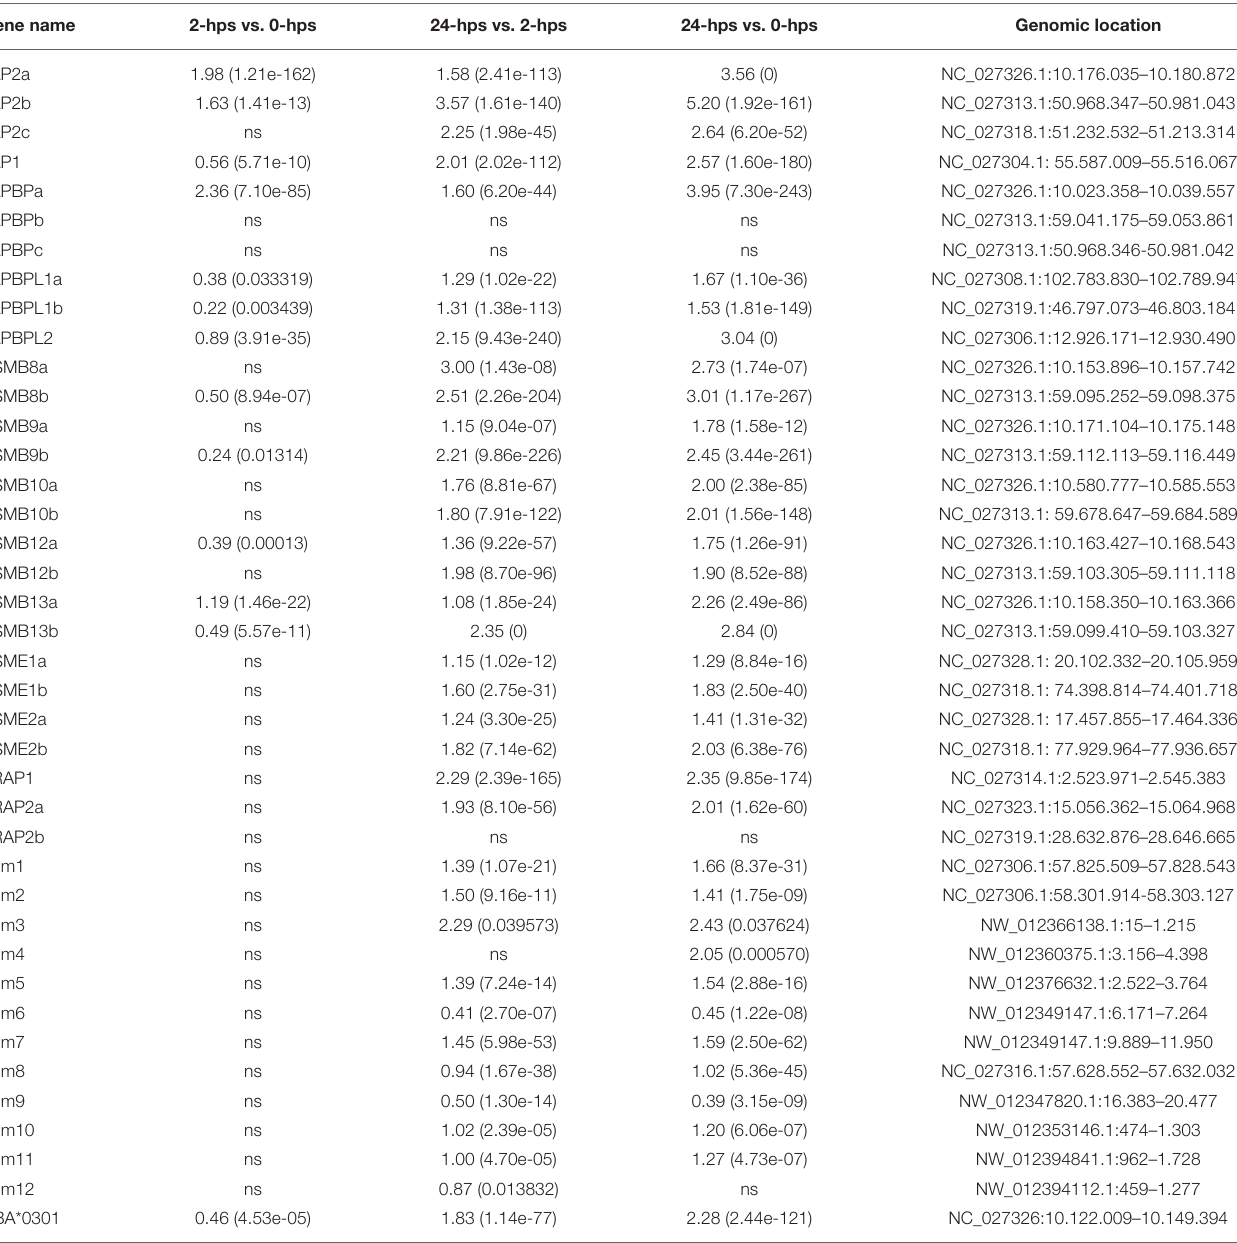
TABLE 3 | Log 2 fold change with adjusted P -values for selected MHCI pathway